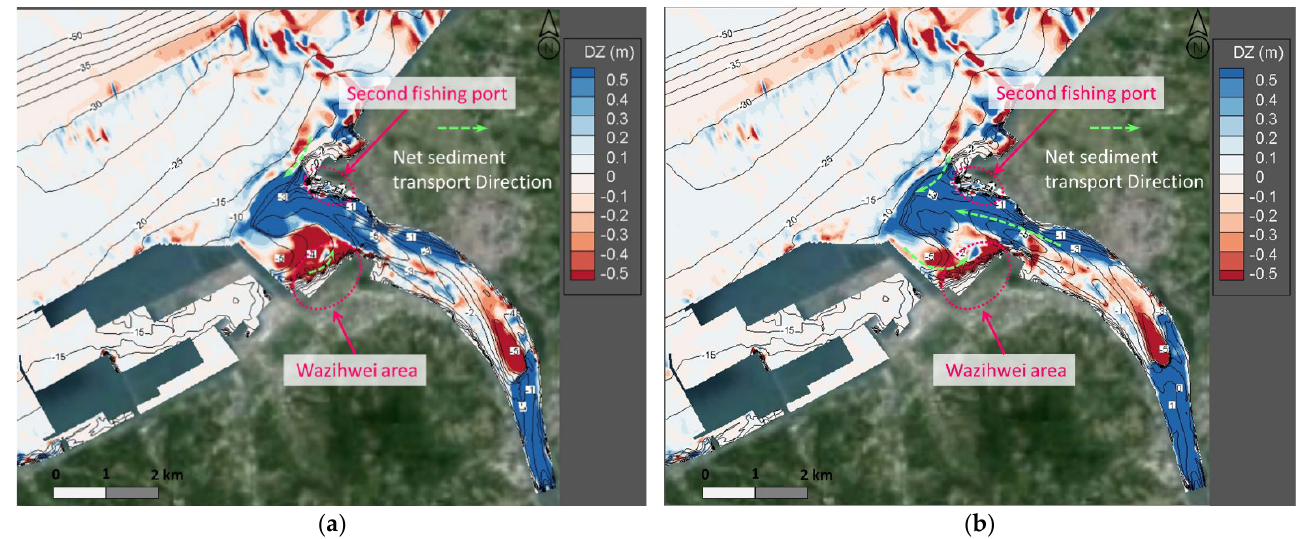
Figure 12. Changes in topographical erosion and deposition at the Tamsui River estuary after the end of monsoon and typhoon seasons in the second year (DZ = bed change, the contour line is bed elevation. The unit is meters for both). ( a ) At the end of monsoon season of the second year. ( b ) At the end of monsoon season and typhoon flood period of the second year.